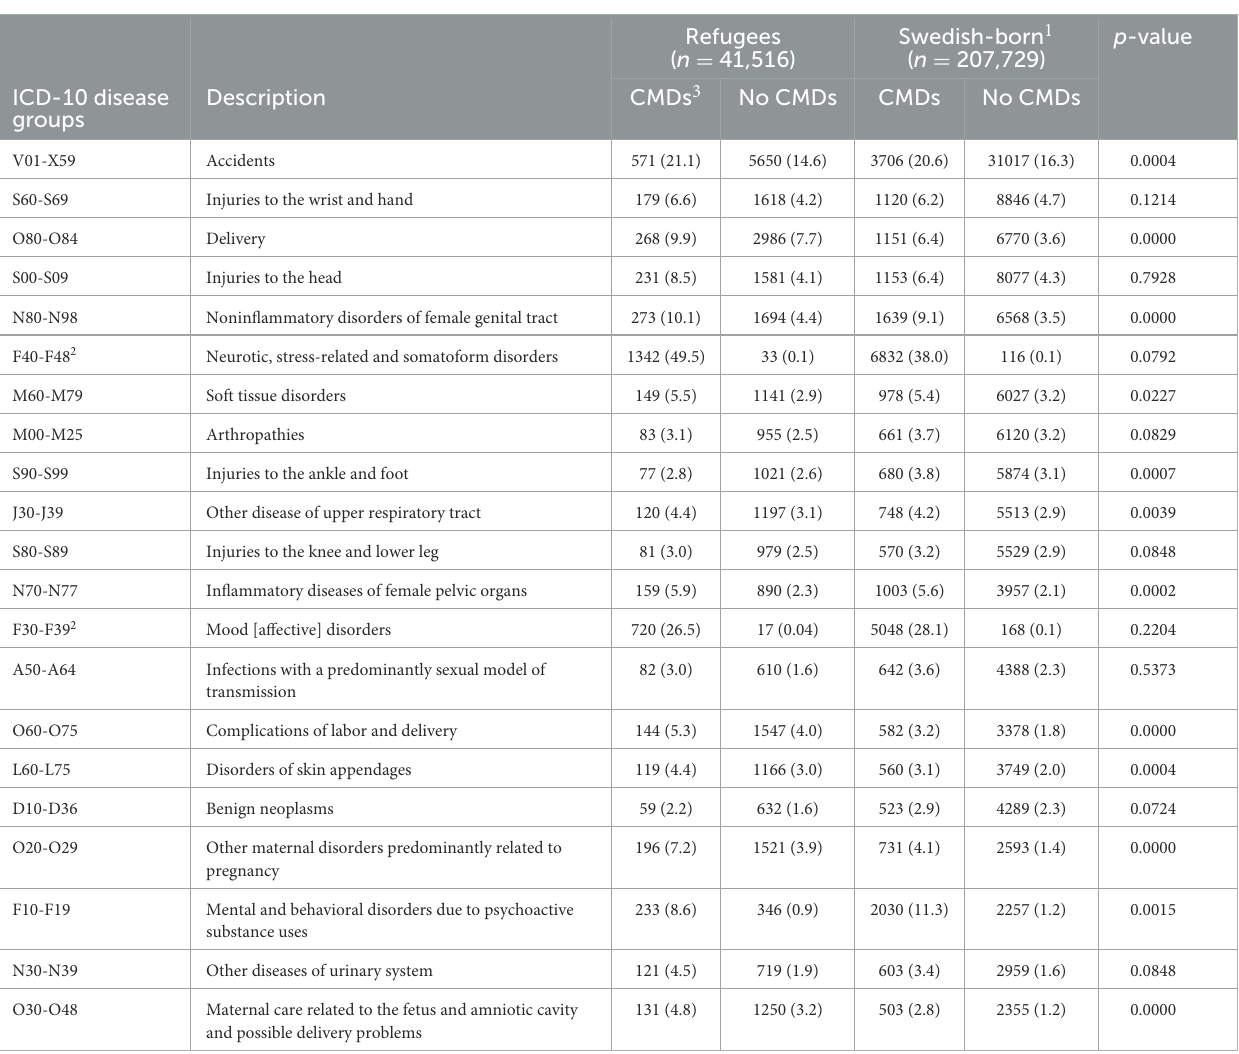
TABLE 3 The top 20 most frequent ICD-10 diagnostic groups ( n =